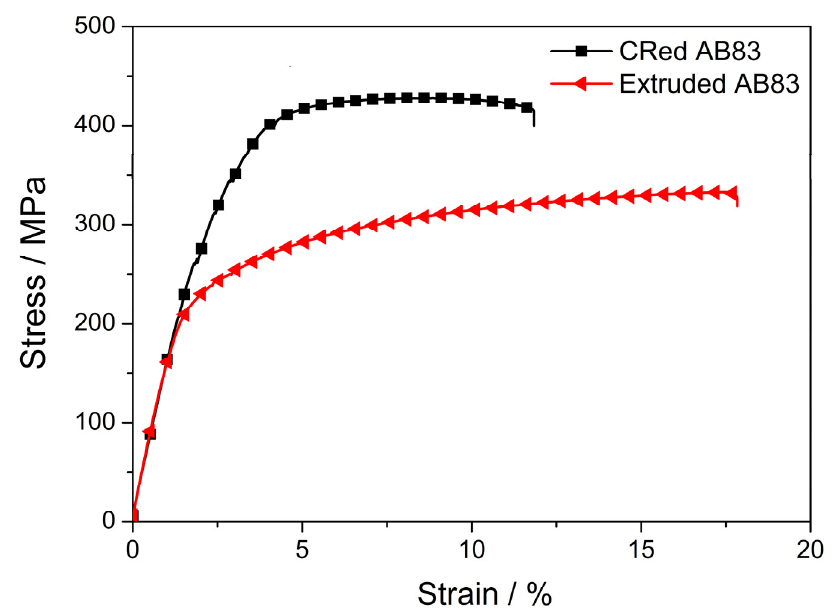
Figure 7. Typical tensile engineering stress–strain curves of the CRed AB83 alloy and of the as-extruded AB83 alloy.